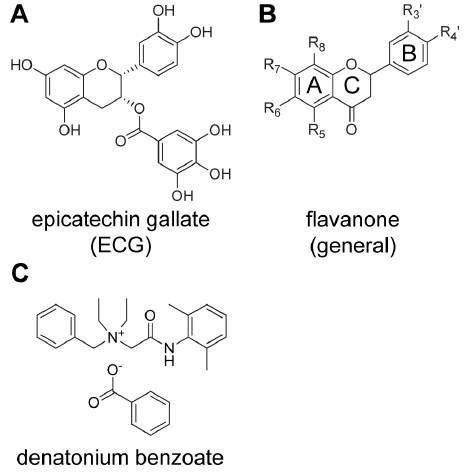
Figure 1. Chemical structures of hTAS2R39 agonist epicatechin gallate (ECG) (A), investigated flavanones (residues specified in Table 1) (B) and hTAS2R39 agonist denatonium benzoate (C). The commonly applied ring-nomenclature for flavonoids (A-, B-, and C- ring) is shown in the general structure formula for flavanones.